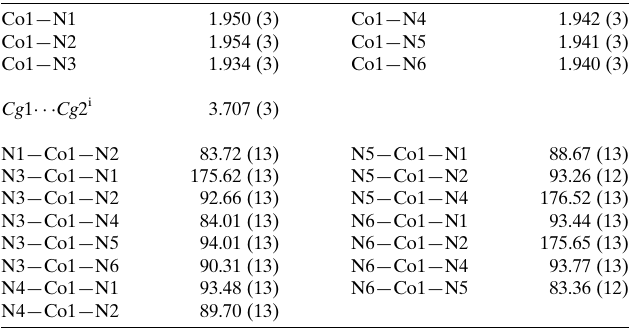
Table 1 Selected geometric parameters (A˚ , (cid:4) ).